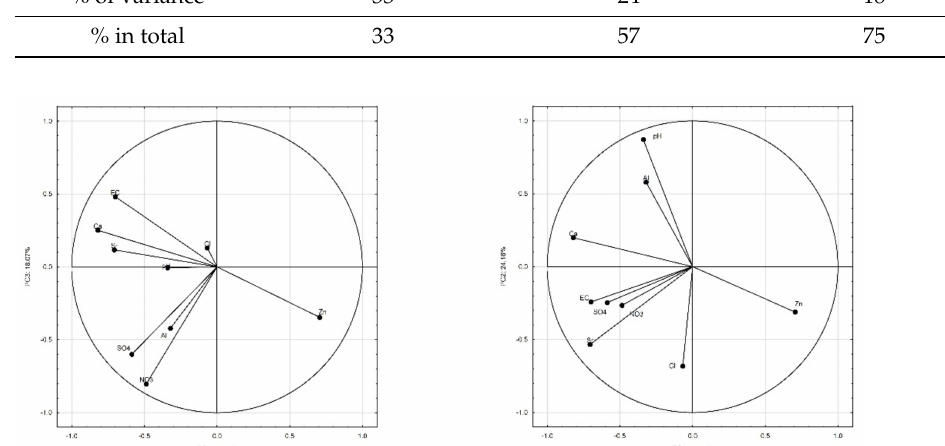
Figure 4. Graphic image of relationships among PC1, PC2 and PC3